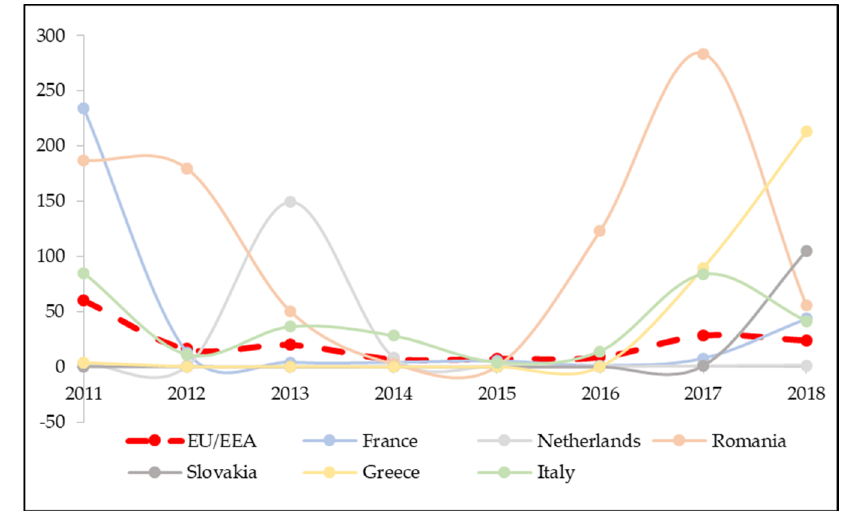
Figure 1. Trends of measles incidence rates between 2011 and 2018. Only the 6 countries reaching the highest annual incidence rates during the period under study were taken into account. The dashed-red curve represents the overall EU/EEA trend.